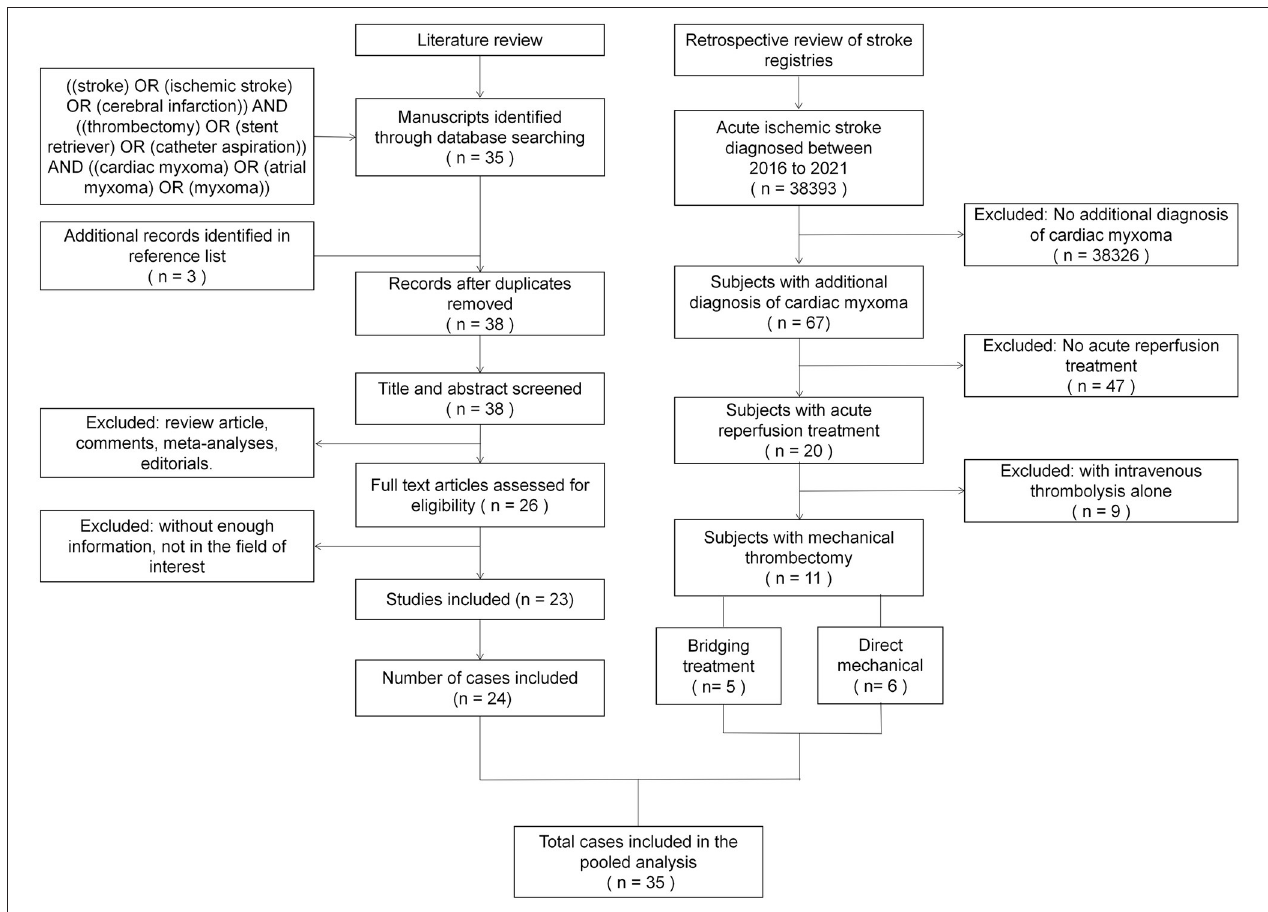
FIGURE 1 | Literature review and retrospective review flow